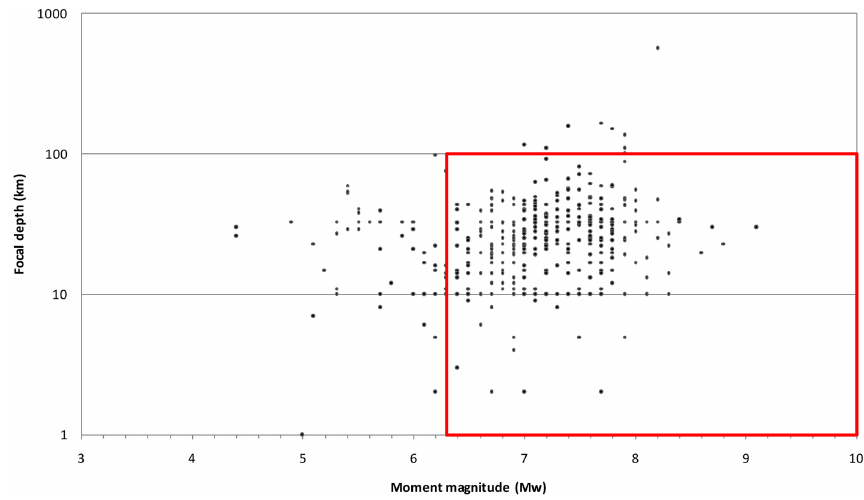
Figure 2. Relationship between earthquake focal depth and moment magnitude for 440 tsunamigenic events of the NGDC/WDS Global Historical Tsunami Database.